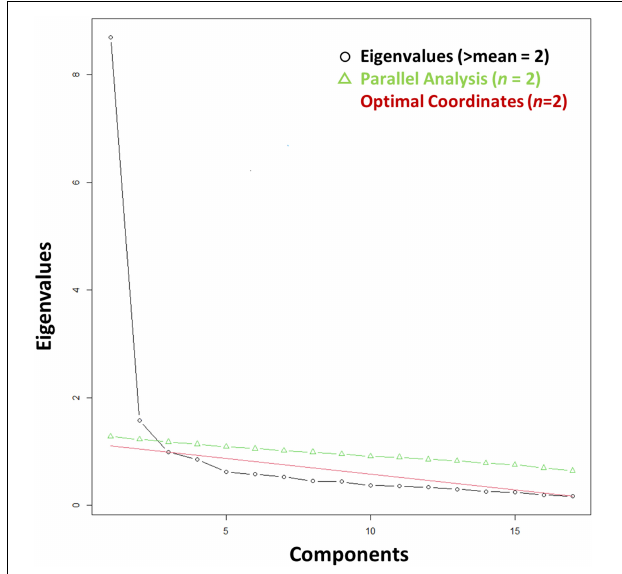
FIGURE 3 | Study 1: Scree plot assessed appropriate number of factors for exploratory factor